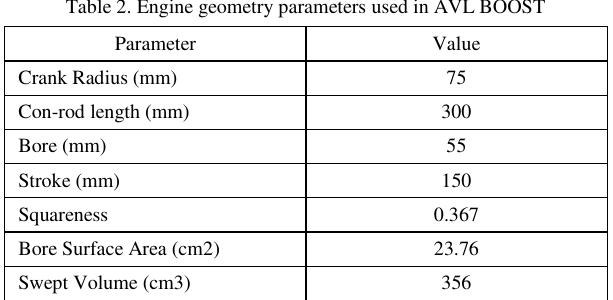
Table 2. Engine geometry parameters used in AVL BOOST